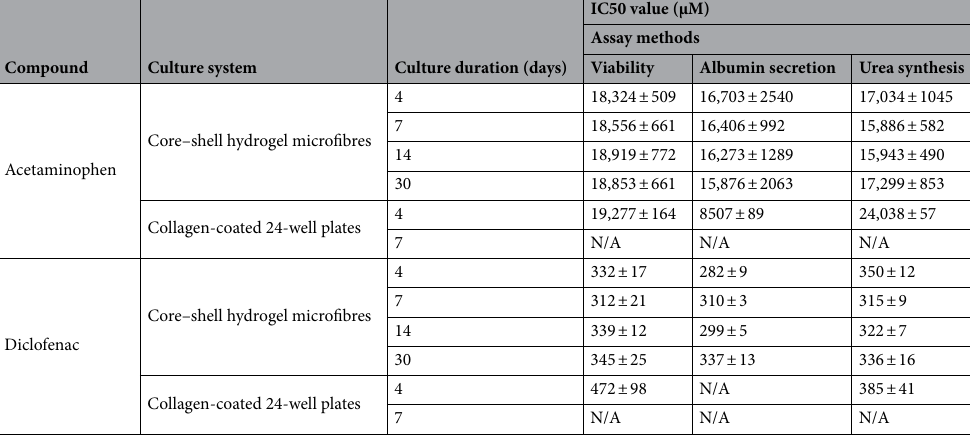
Table 1. 50% inhibitory effect (IC50 values) for acetaminophen and diclofenac relating to viability, albumin secretion, and urea synthesis of primary rat hepatocytes cultured either in cell fibers for 4 days, 7 days, 14 days, and 30 days, or in collagen-coated 24-well plates for 4 days and 7 days. Data are presented as the mean ± standard deviation of at least four independent cell fibers and four collagen-coated wells from collagen- coated 24-well plates.